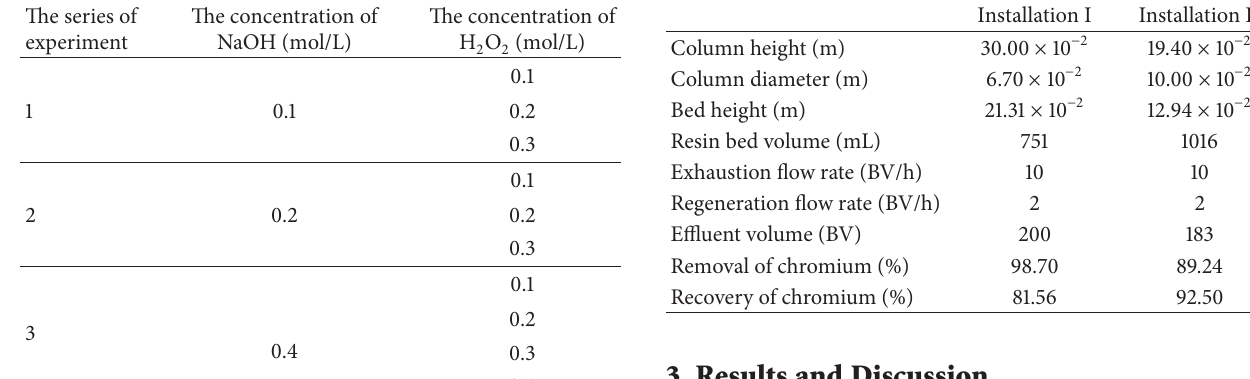
Table 2: The composition of the regenerant solutions. The series of The concentration of experiment